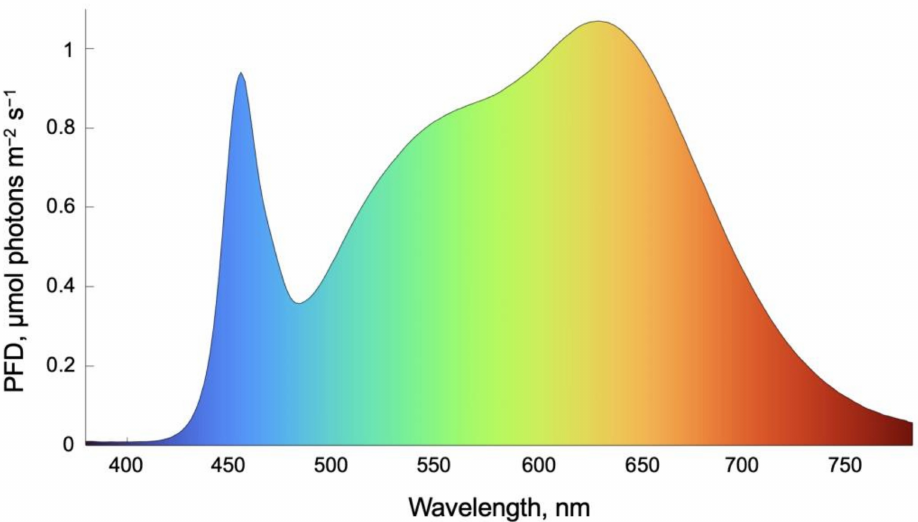
Figure 6. Spectral quality for Environmental Lights PN 4000k-CC2835LM-240-14-reel as PFD in µ